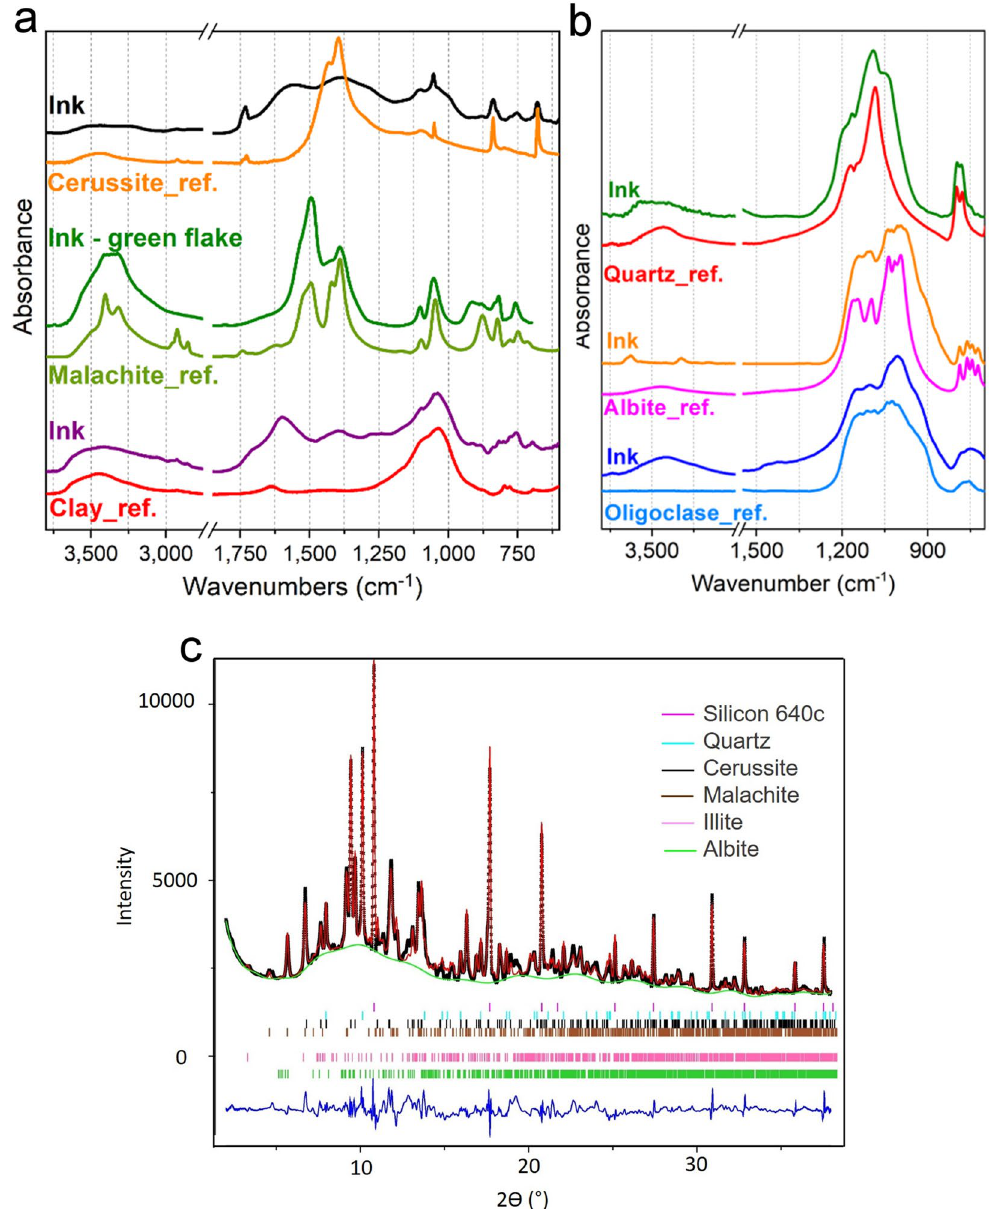
Figure 3. ( a,b ) Infrared spectra of several ink samples and possible reference spectra from the database (Kimmel Center for Archaeological Science Infrared Standards Library, https:// www. weizm ann. ac. il/ kimmel- arch/ infra red- spect ra- libra ry); ( c ) XRPD Rietveld refinement profile fit of the ink sample: black crosses are the experimental data, in red the calculated pattern. The residuals are displayed on the bottom in blue and the reflection ticks of each phase with the colours reported in the